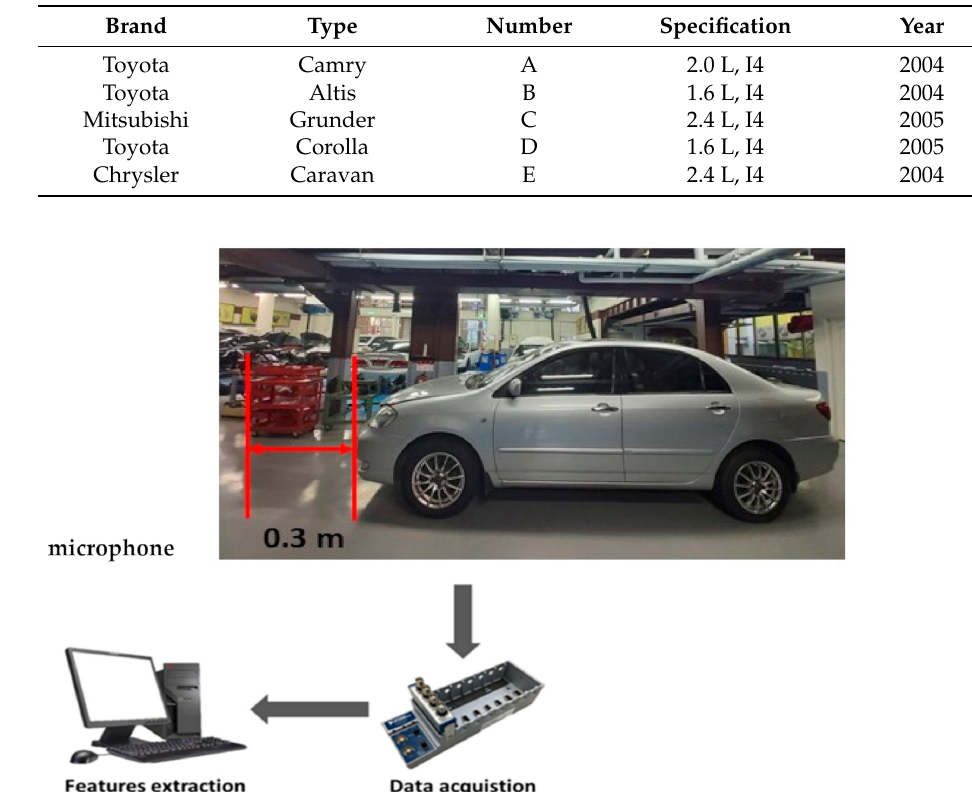
Table 1. Specification of traditional vehicles in the experiment.